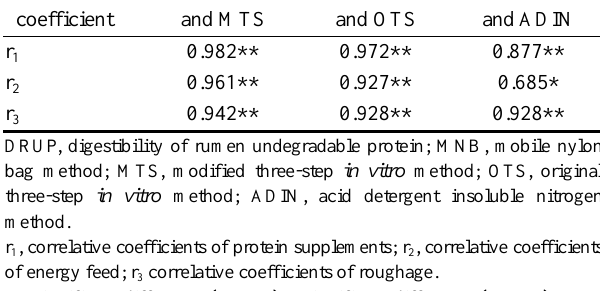
SEM, standard error mean; CP, crude protein; DM, dry matter; SP, soluble protein; NDF, neutral detergent fiber; EE, ether extract.